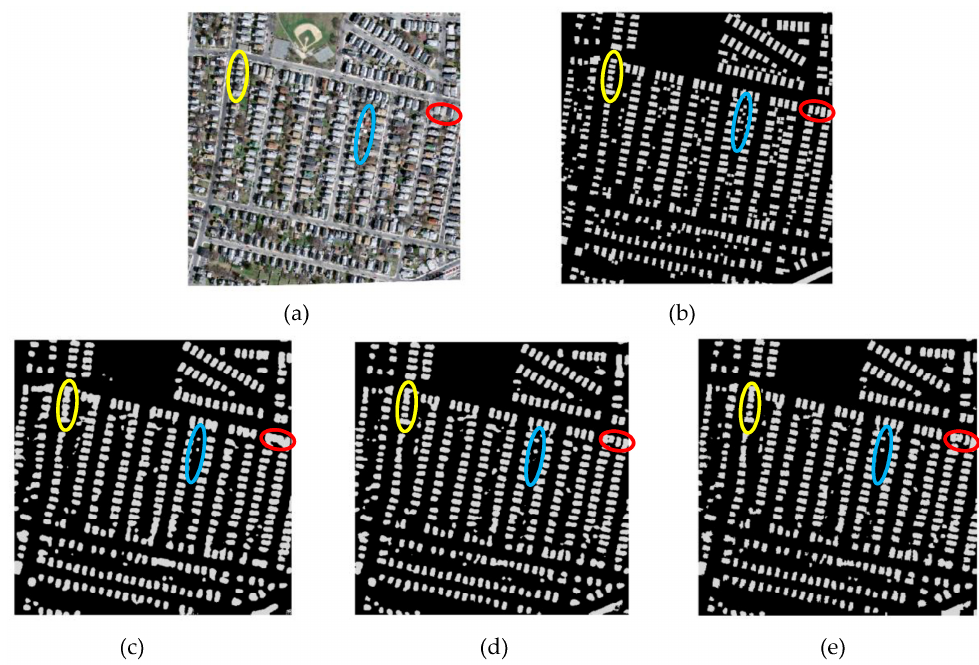
Figure 5 . Visual comparison of three variations of the proposed techniques using sample aerial test images of the Massachusetts area. ( a ) original input image; ( b ) ground-truth map; ( c ) output of FCN-8s; ( d ) output of ELU-FCN; and ( e ) output of ELU-FCN-CRFs.